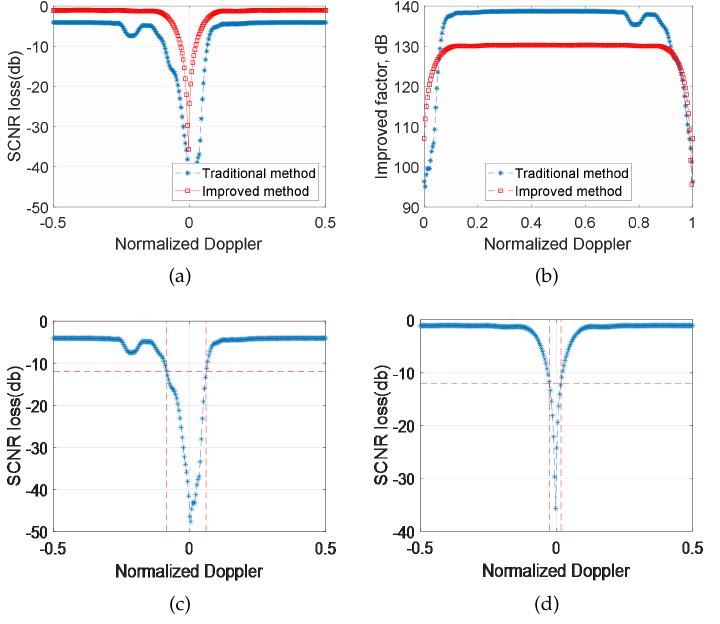
Figure 13. STAP performance indexes. ( a ) Output SCNR Loss Diagram. ( b ) SCNR improvement factor. ( c ) MVD calculation of traditional method ( d ) MVD calculation of proposed method.